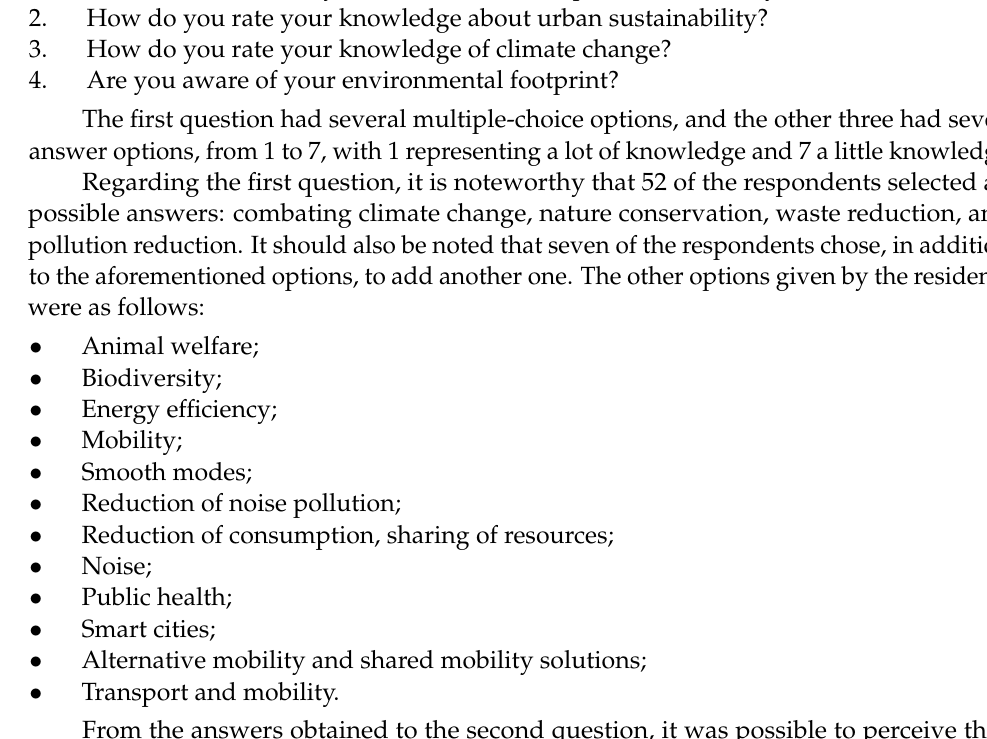
Figure 8. Number of responses by age group.